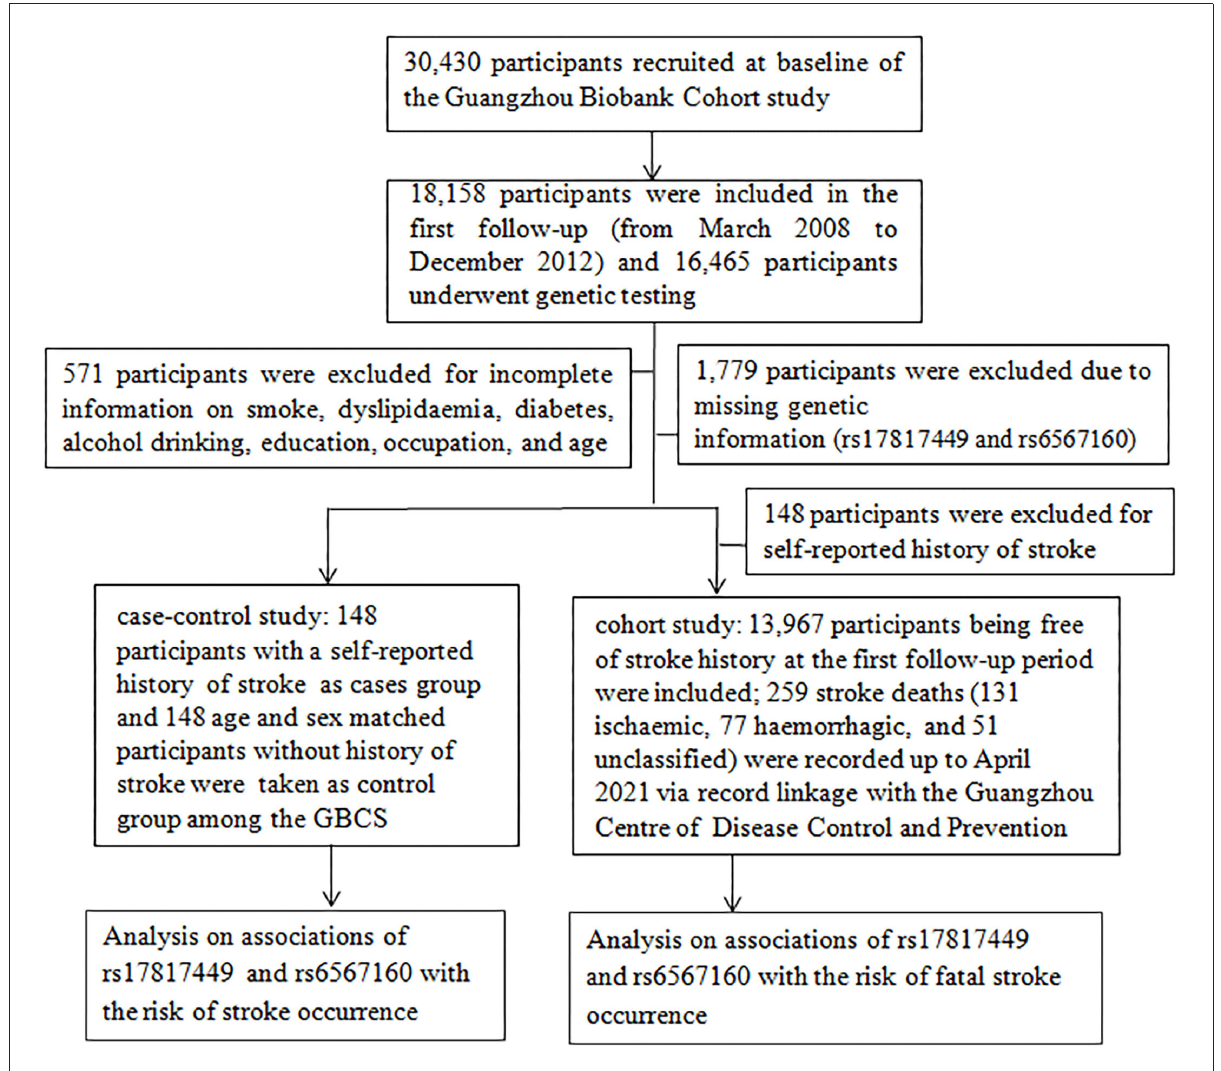
FIGURE1 A flow diagram of the selected participants and study design for the analyses of this study.